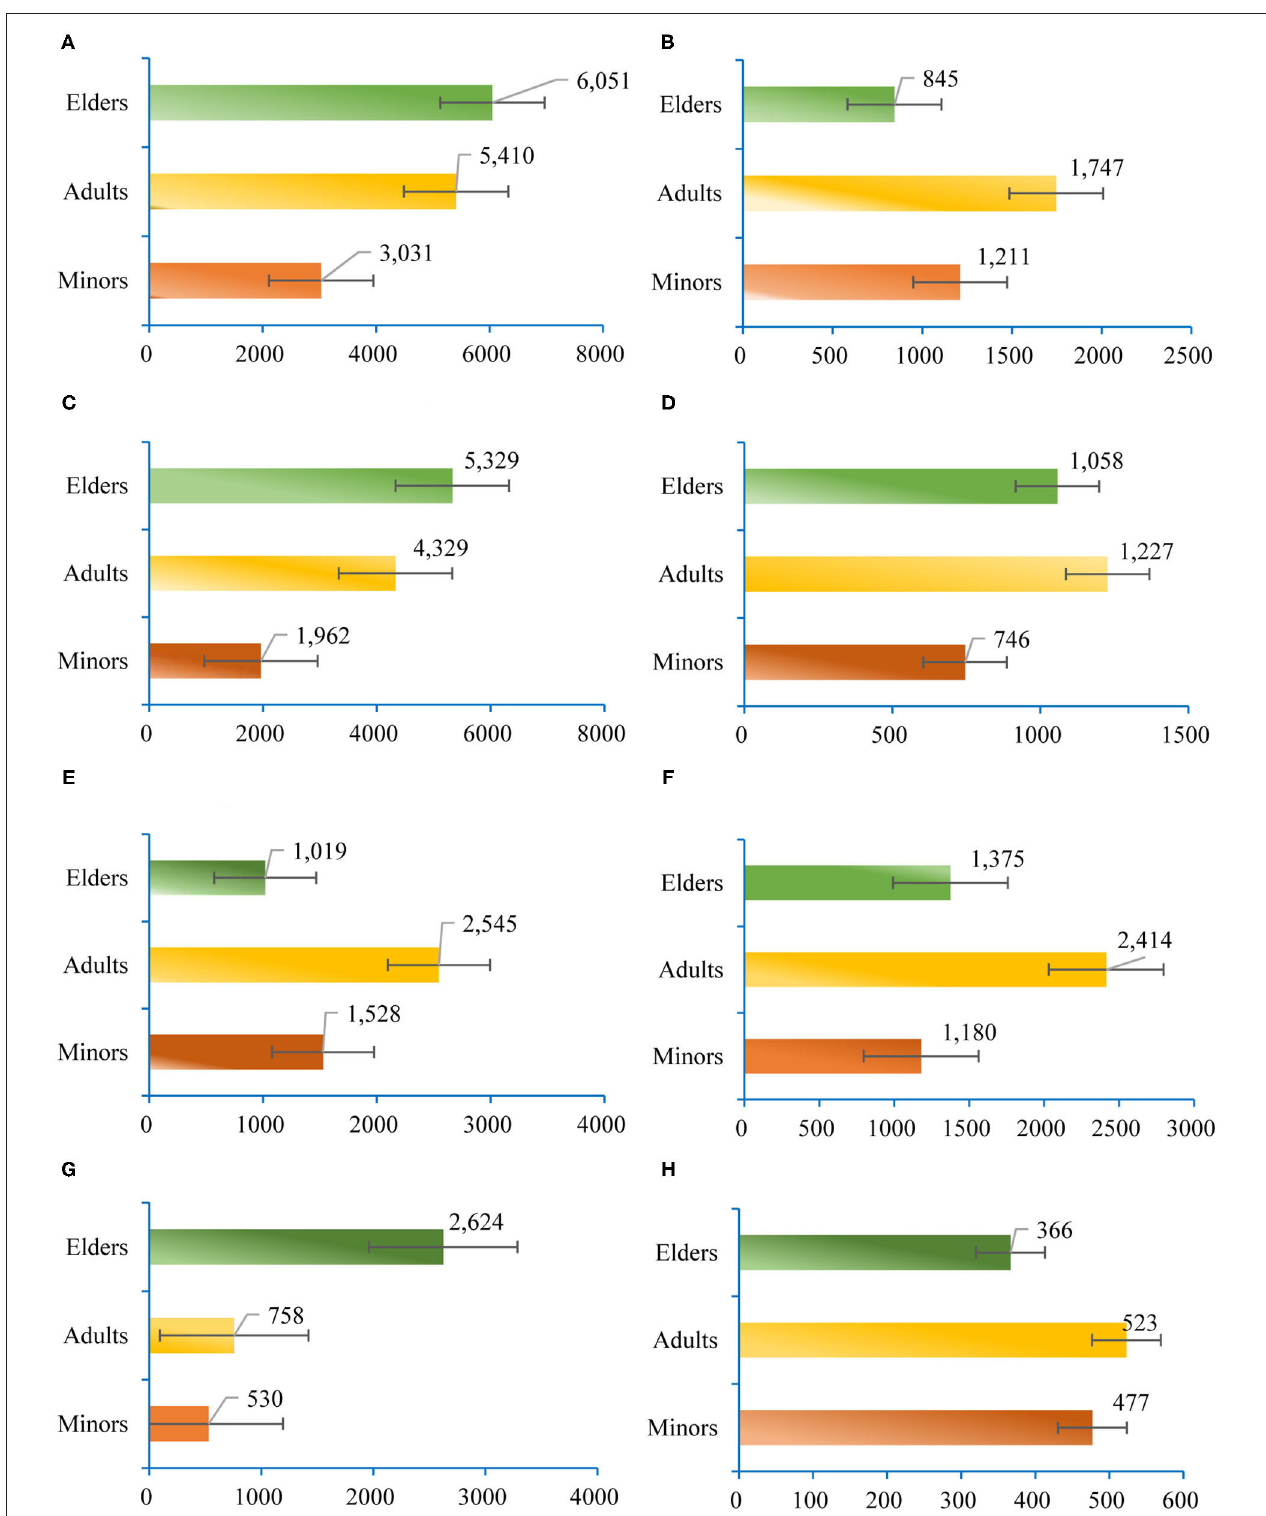
FIGURE 2 | Demand for goods and services in different life cycle stages (Unit: CNY). (A) Expenditure on food, tobacco, and alcohol. (B) Clothing expenditure. (C) Housing expenditure. (D) Expenditure on facility and services. (E) Expenditure on communication and transportation. (F) Expenditure on education and entertainment, and cultural activities. (G) Healthcare expenditure. (H) Expenditure on miscellaneous goods and